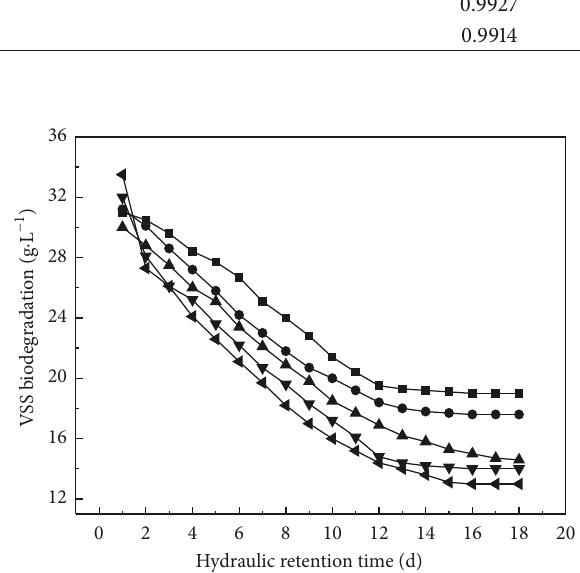
Figure 5: Effect of temperature on VSS degradation. Tempera- ture/ ∘ C: ◼ 20; e 30; 󳵳 40; 󳶃 50; 󳶣